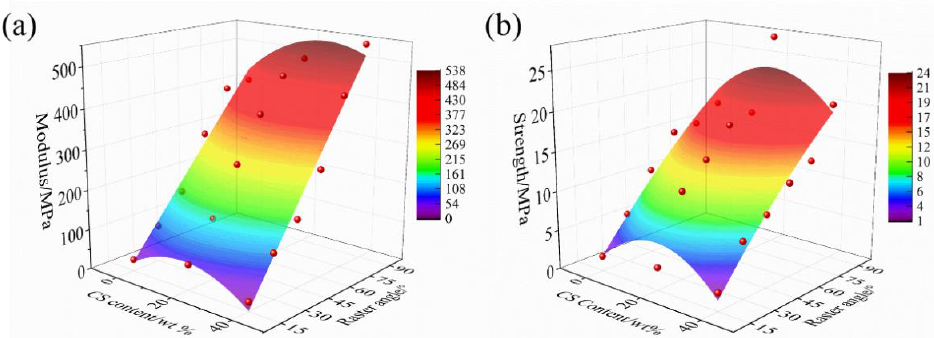
Figure 8. The changing law of modulus ( a ) and strength ( b ) with different CS content and raster angle.